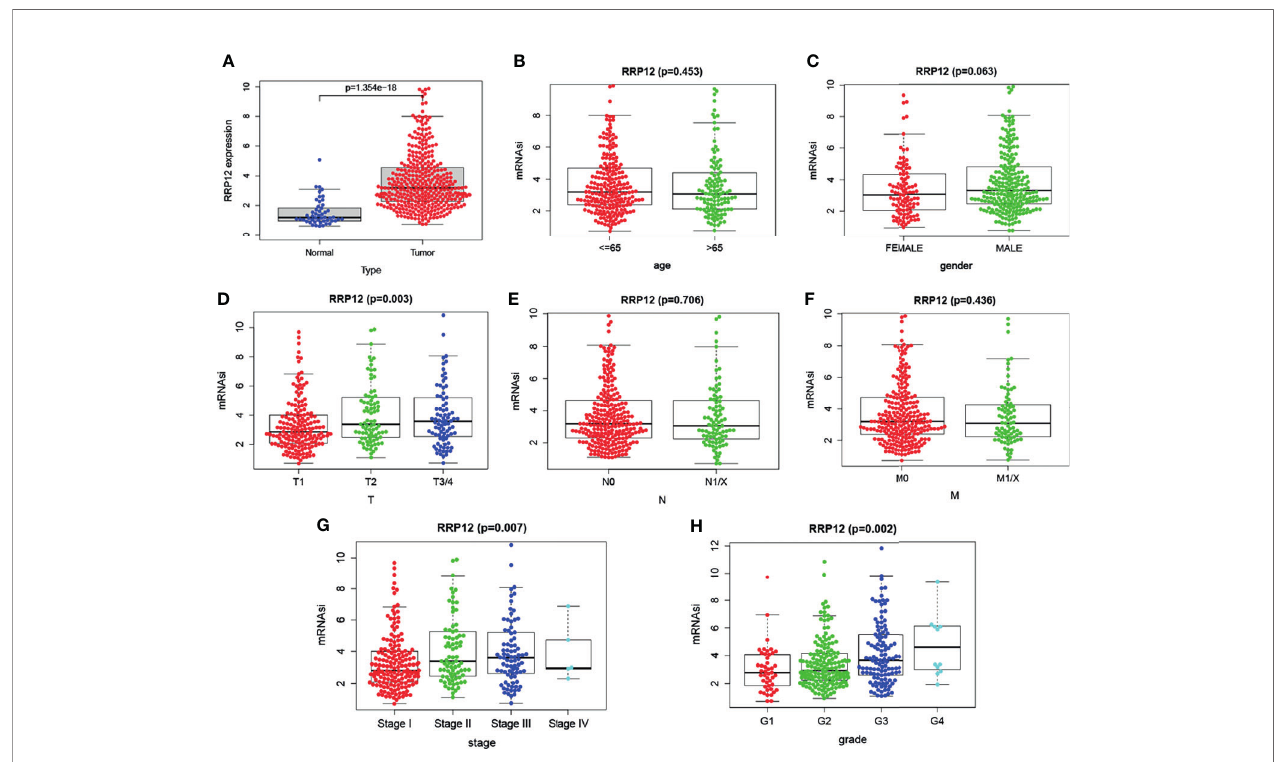
FIGURE 4 | The analysis of RRP12 in TGCA. (A) The analysis of the expression between tumor tissue and normal tissue. The results show that RRP12 is highly expressed in tumors. (B – H) The relationship between the expression of RRP12 and the clinicopathological parameters of HCC patients. p<0.05 is statistically signi fi cant.